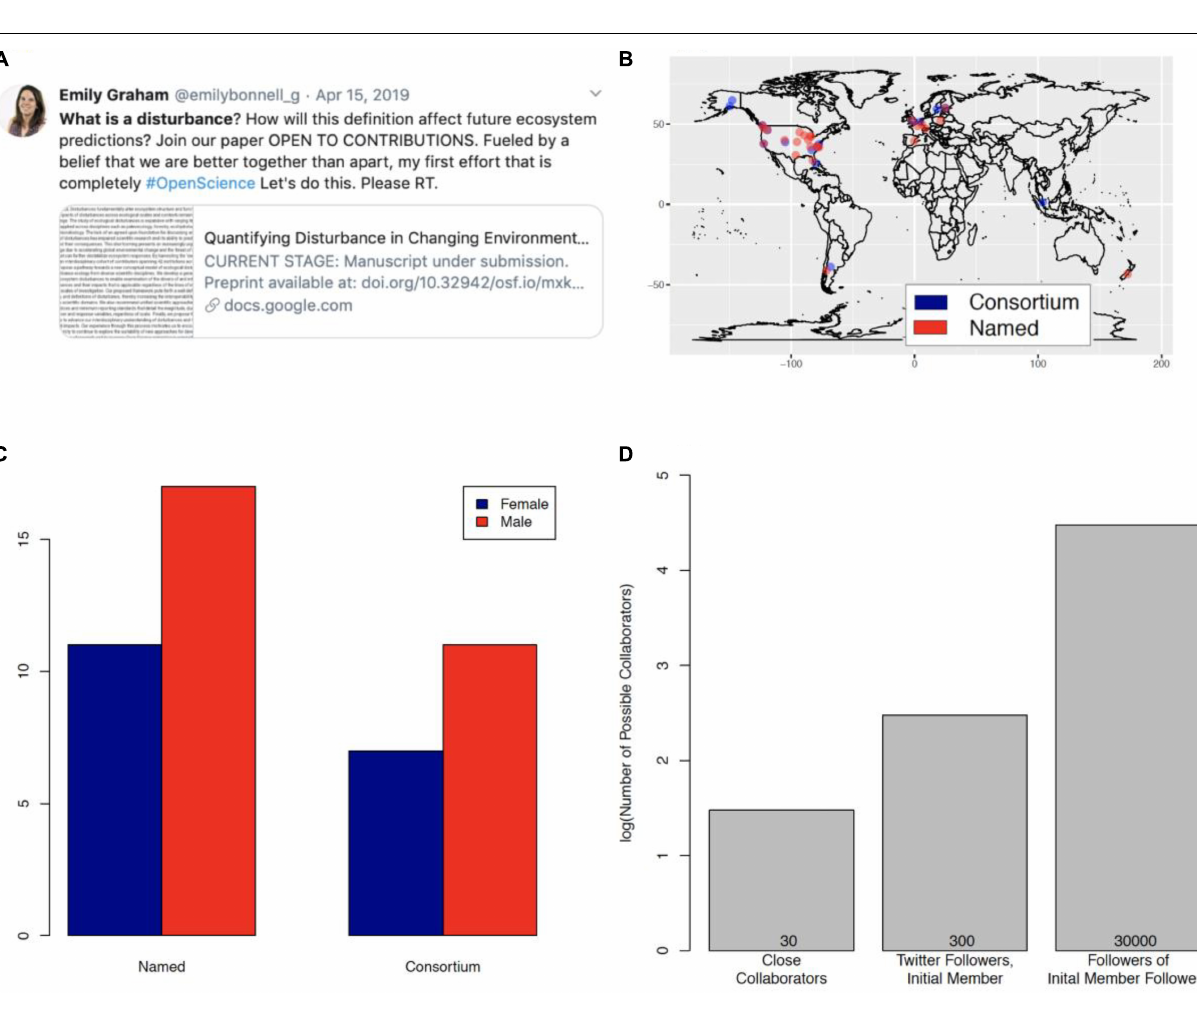
FIGURE 2 | Contributors Recruited through Open Call. We used of Twitter to recruit a diverse cohort of contributors. (A) shows an example of our recruitment process, (B) shows the global distribution of contributors, (C) shows contributor gender distribution, and (D) shows the power of social media for extending collaborator